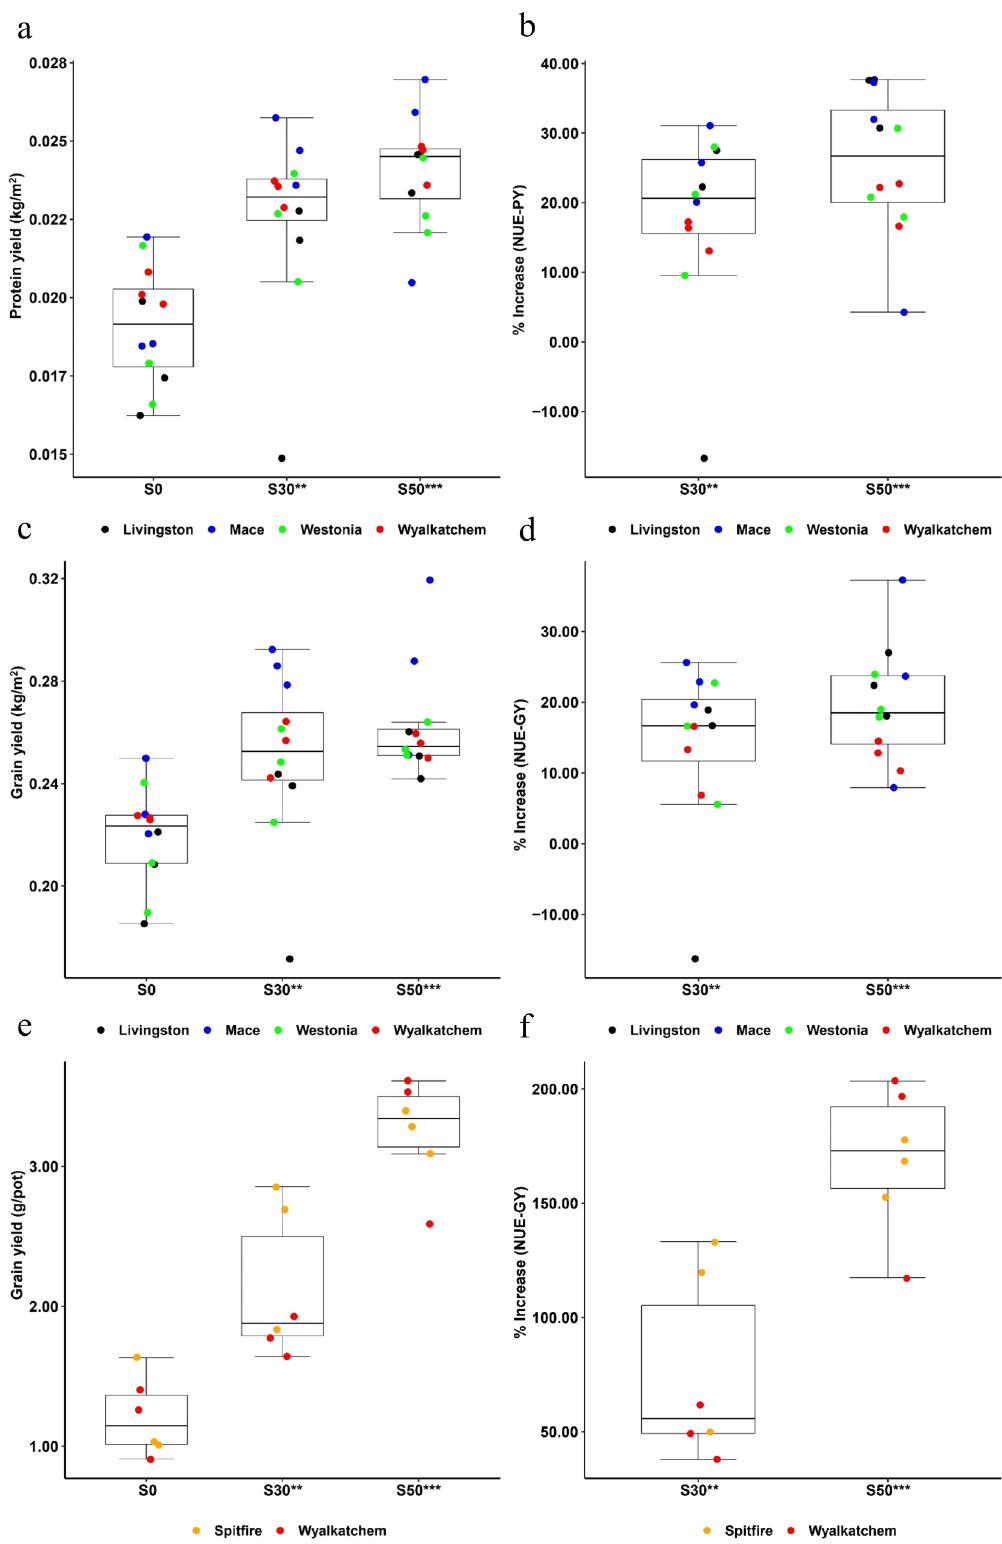
4.8 to 3.7% and 4.1 to 3.2%, respectively, which represented decreases of 25.9, 23.4, 22.9 and 22.0%. At S50, the average ω 1,2- gliadins% was increased by 14.8%, 31.9%, 14.6% and − 7.3%, respectively ( P < 0.001 at S30, P > 0.05 at S50, T -test, Supple- mentary Data 1 and Fig. 3e). The average α / β -gliadins% of cul- tivars Livingston, Mace, Westonia and Wyalkatchem